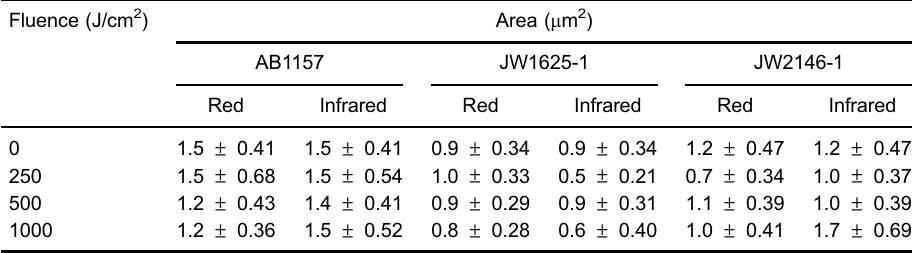
Data are reported as means ± SD of three independent assays. Experiments were carried out in duplicate. There were no signi fi cant differences compared to the control group not exposed to lasers (P 4 0.05, Tukey study indicated that sub-lethal oxidative lesions in